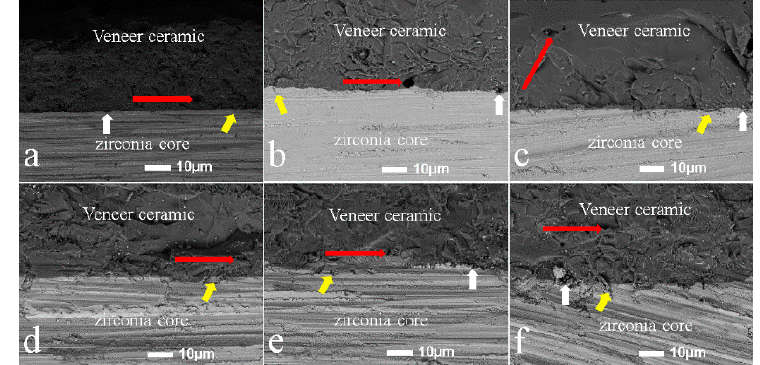
Figure 8. SEM (X500 magnifications) images illustrating different interfaces after coating zirconia with v–c material. The core material was treated by: milling ( a ); grinding ( b ); sandblasting ( c ); L3 ( d ); L4 ( e ) and L5 ( f ). The white arrows show adhesion between the veneer/core material; the yellow arrows show micro-cracks following different surface treatments; the red arrows show holes formed within the v–c layer which was deposited on the zirconia.